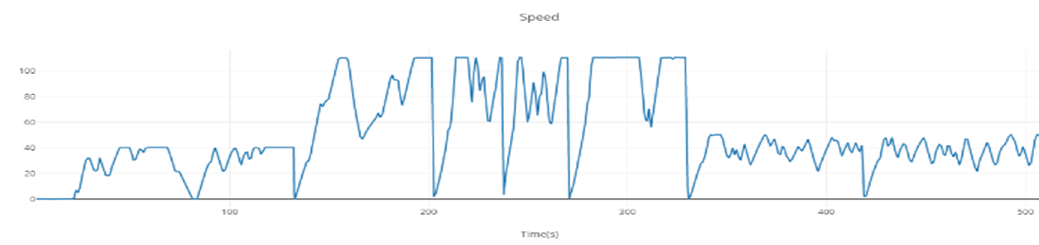
Figure 7. System data—Steering wheel rotation data tracking.